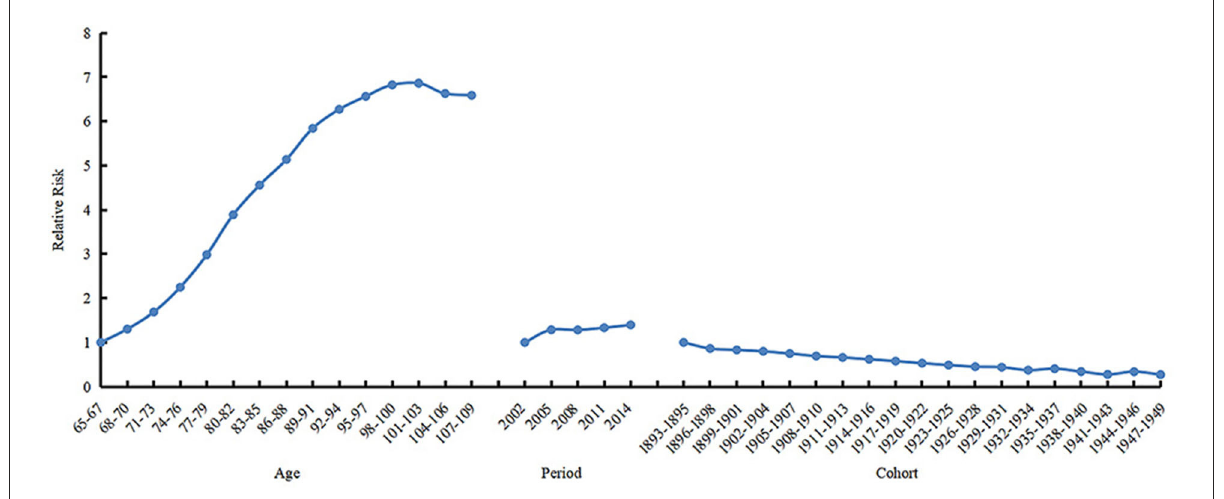
FIGURE5 Sensitivity analysis with the frailty measured by frailty phenotype: Relative risks of age (left), period (mid) and cohort (right) effects on prevalence of frailty.